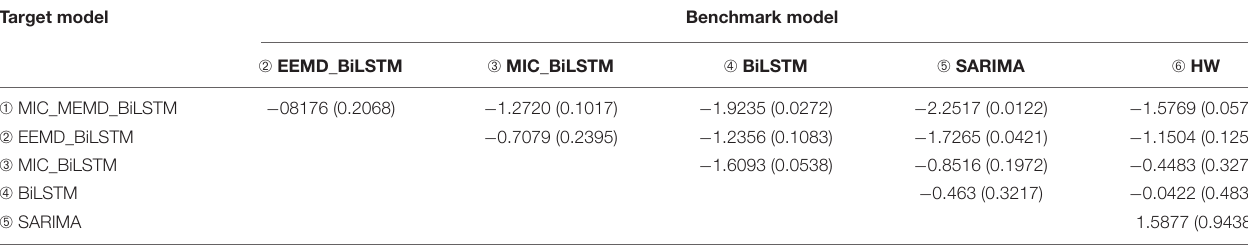
TABLE 5 | Diebold-Mariano test results of different models for Beijing Capital International Airport (BCIA) dataset. Target